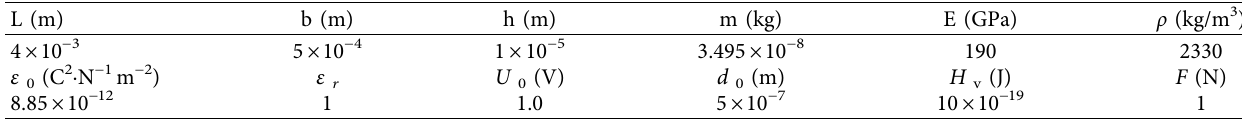
Table 2: Parameters of the sensor system.